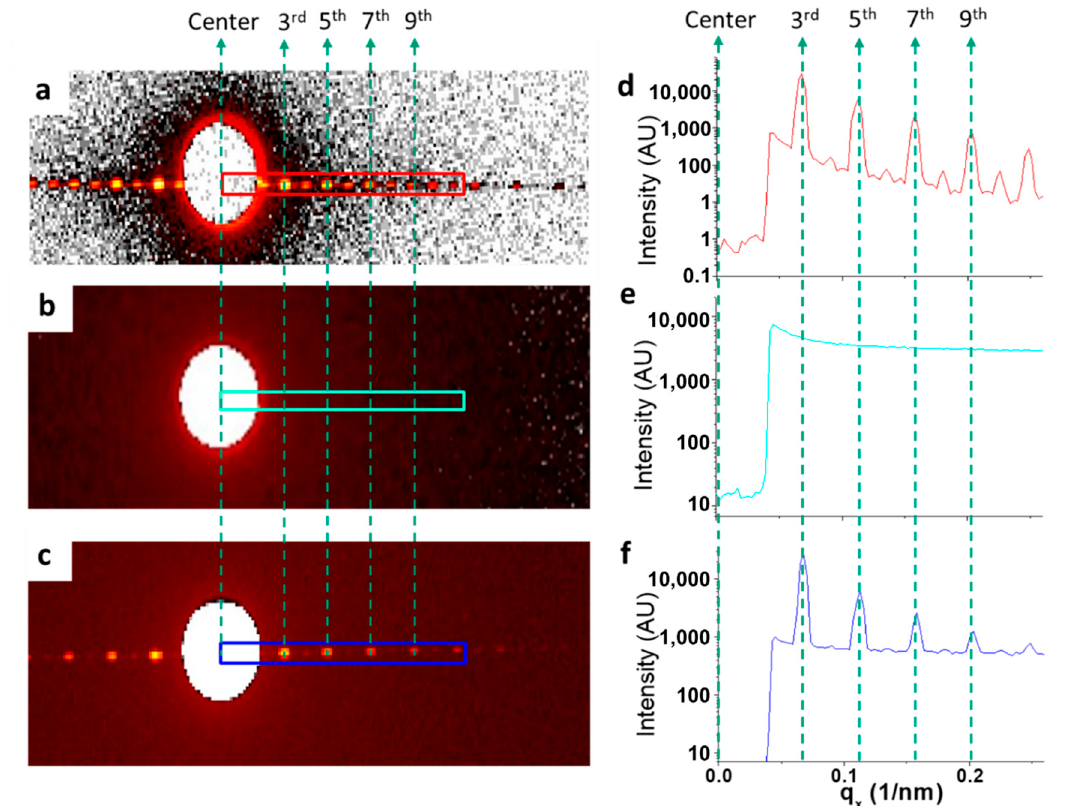
Figure 3. The scattering patterns recorded on a 2D detector of Si grating, National Institute of Standards and Technology Standard Reference Materials (NIST SRM) 3600, and the composite sample at a separation distance of 537 μ m are given in ( a – c ), respectively. The corresponding averaged intensities are given in ( d – f ), respectively. For ( d – f ), the intensities presented were from their sector